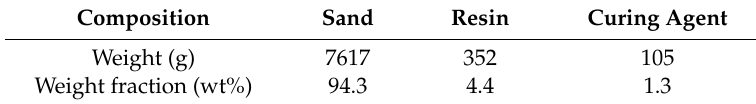
Table 2. The mix proportion of resin-based permeable brick (RBPB).